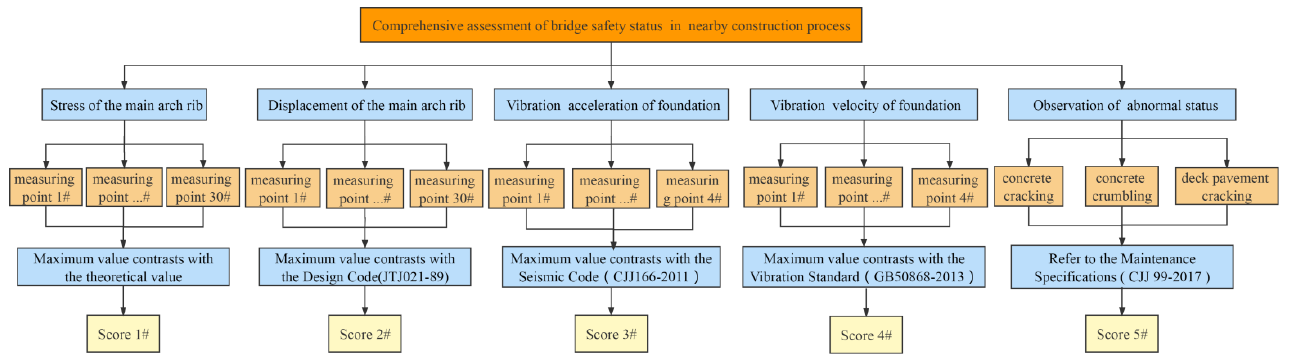
Figure 5. Hierarchical division of comprehensive assessment of bridge safety status in the nearby construction process.